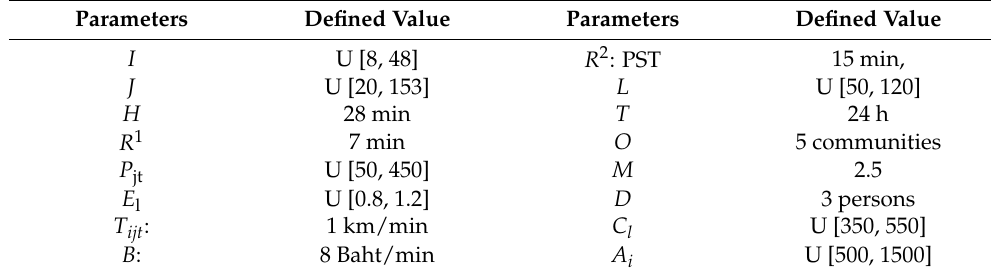
Table 9. Random parameter settings.